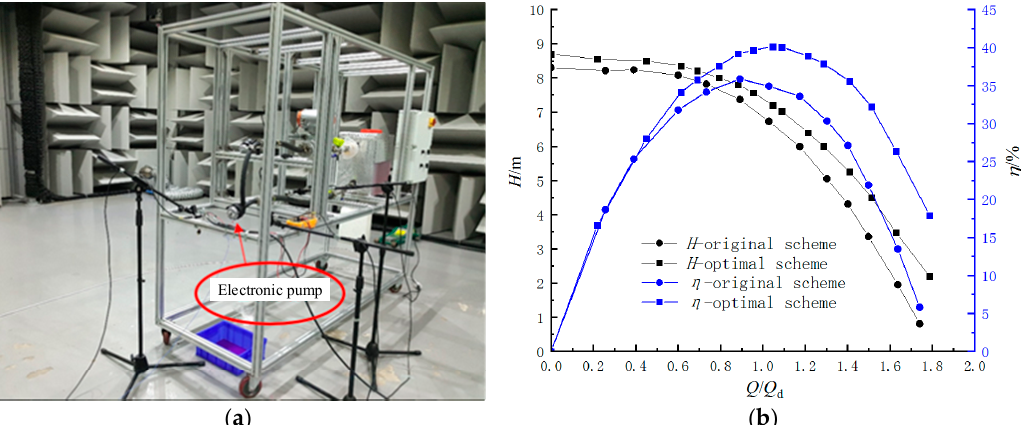
Figure 21. Comparison of the origin and optimal scheme. ( a ) Test rig; ( b ) Comparison pump performance results.